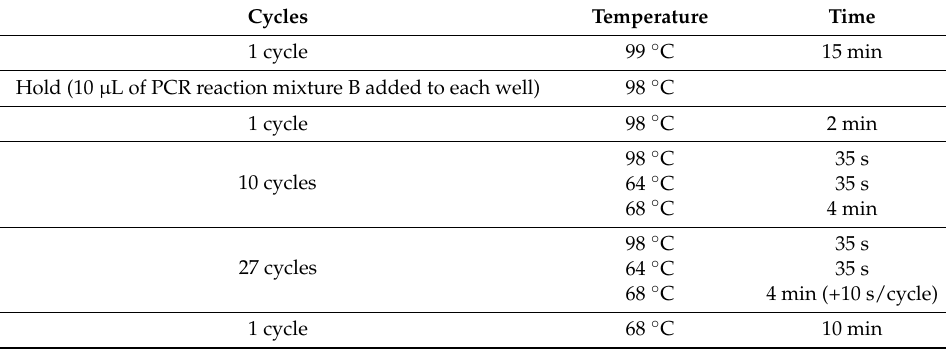
Table 2. PCR thermal cycling conditions for the fragile X assay using a chimeric